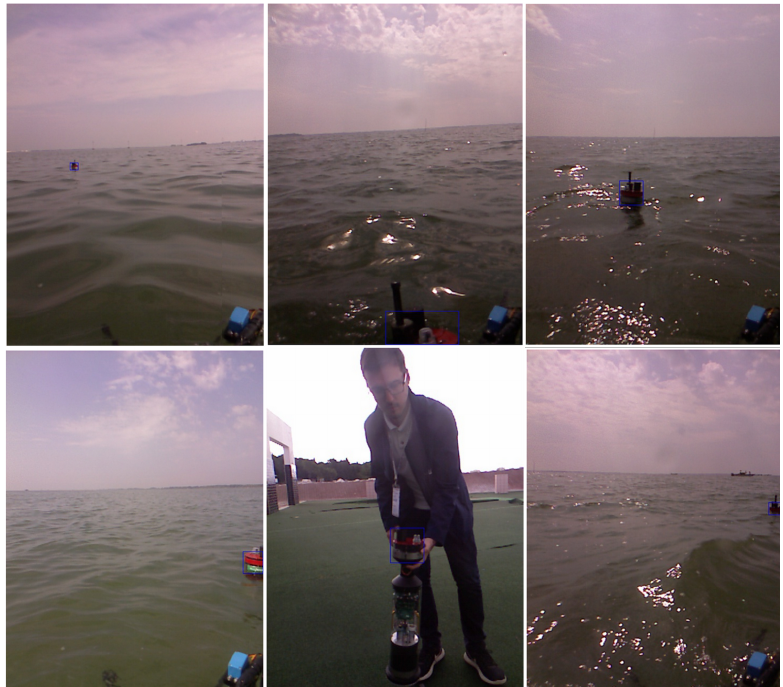
Figure 15. Challenging detection examples (output aMussel bounding boxes shown in blue).